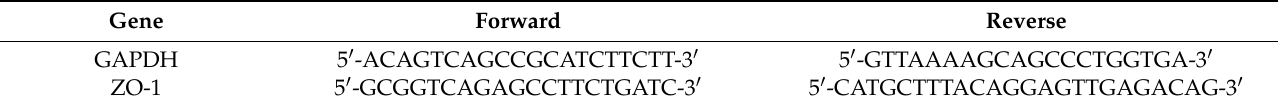
Table 1. Primers used for RT-qPCR